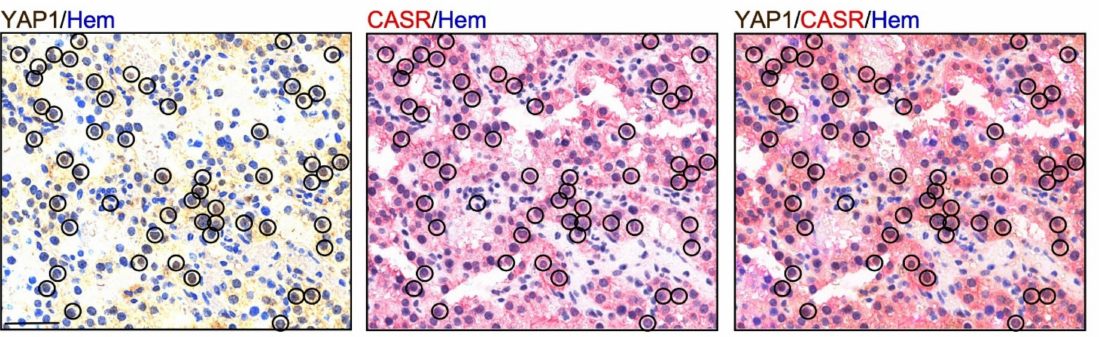
Figure 3. Coexpression of YAP1 and calcium-sensing receptor (CASR) in parathyroid tumor cells. Representative images of the double immunohistochemistry (IHC) are shown for each staining as well as the double staining. Scale bar, 50 µ